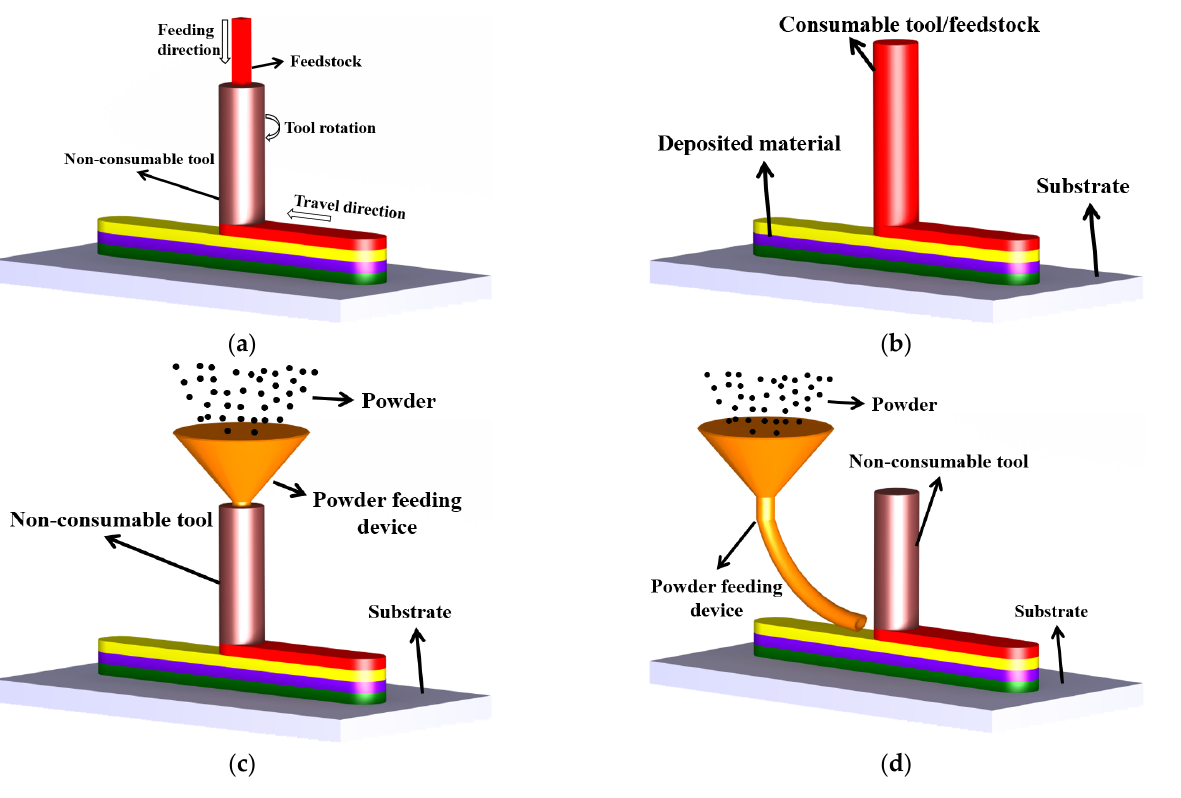
Figure 1. Schematic of the AFSD process with different modes. ( a ) Rod with non-consumable tool. ( b ) Consumable tool. ( c ) Powder with non-consumable tool. ( d ) Powder with non-consumable tool.